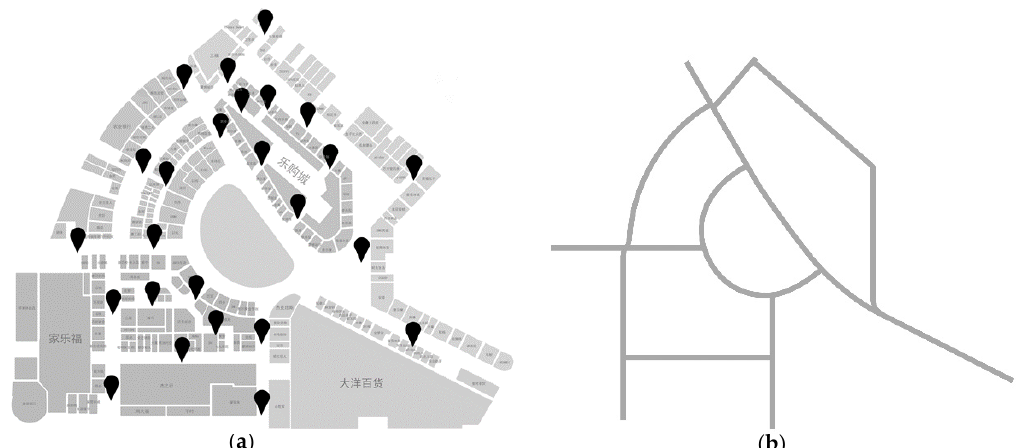
Figure 2. ( a ) The distribution of pedestrian flow test points and ( b ) highlighted paths of the experimental map. ISPRS Int. J. Geo-Inf. 2020 , 9 , 82